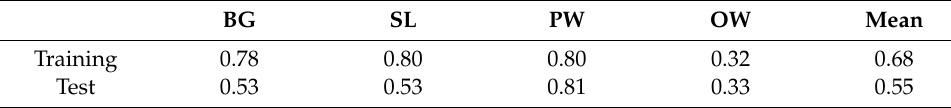
Table 14. IoU scores for Soybeans in Experiment